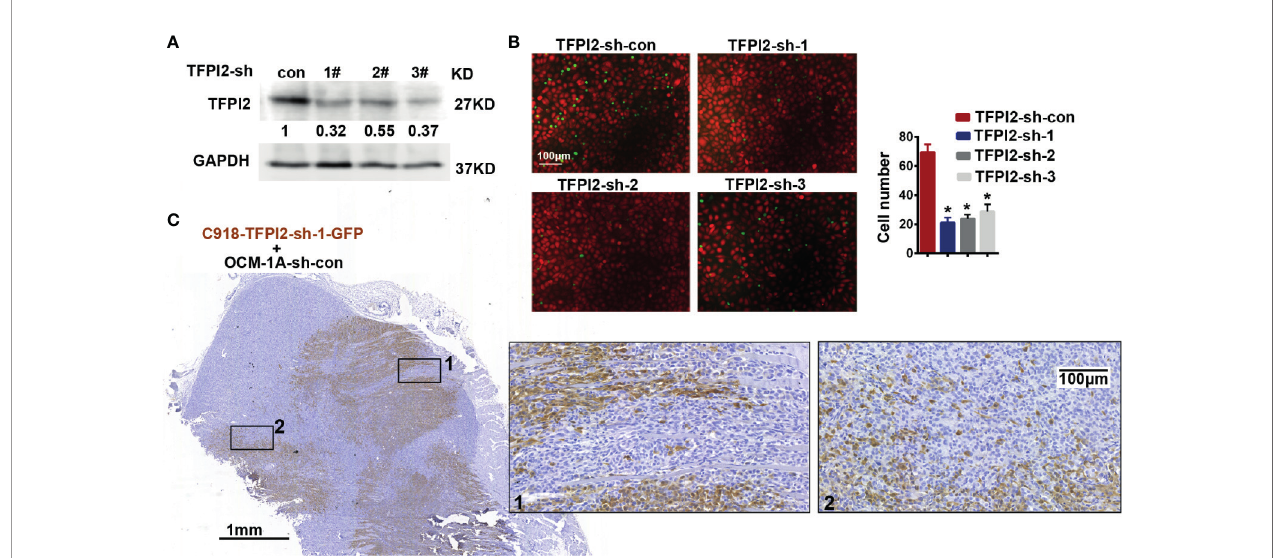
FIGURE 5 | Knockdown of TFPI2 inhibits angiotropic migration of the highly invasive cell line. (A) TFPI2 expression levels in whole cell lysate were determined by western blotting and quantitated relative to sh-con cells. (B) Number of adherent C918 cells with normal TFPI2 levels (sh-con) or TFPI2 knockdown (sh-TFPI2-1-3) are shown and counted. * P < 0.05. (C) The distribution of C918 cells with TFPI2 knockdown is shown in a coxenograft model. GFP staining is shown. Dark brown represents C918-sh-TFPI2-GFP cells, and GFP-negative areas indicate OCM-1A-sh-con cells.